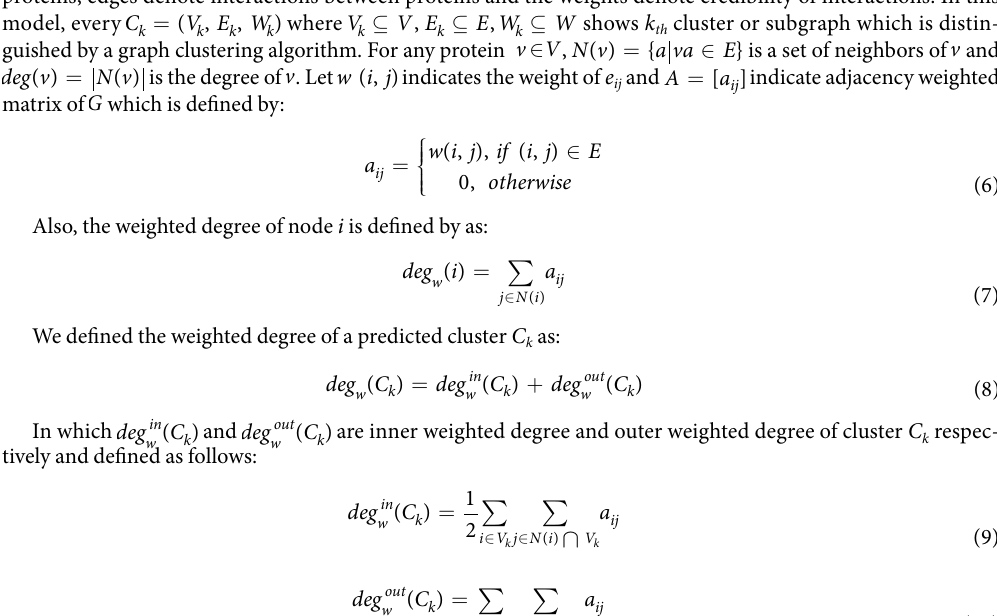
Table 6. Influence of removing and putting hubs back in all methods used in this